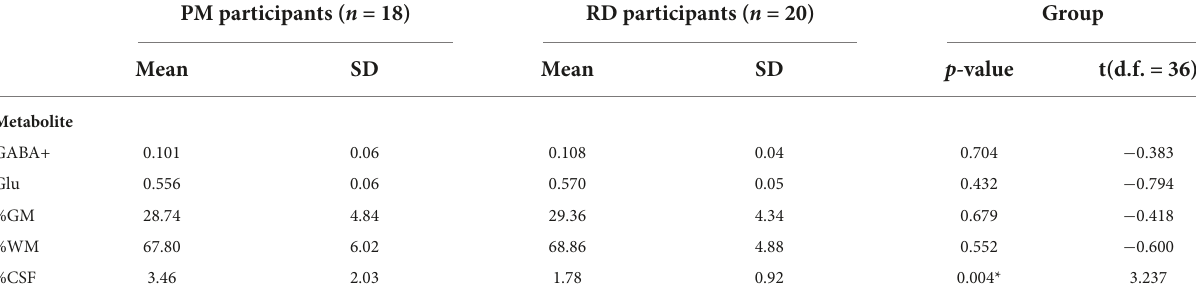
TABLE 1 Creatine and phosphocreatine-referenced GABA+ and Glu concentrations and brain tissue composition within the LDLPFC of healthy PM and RD women.